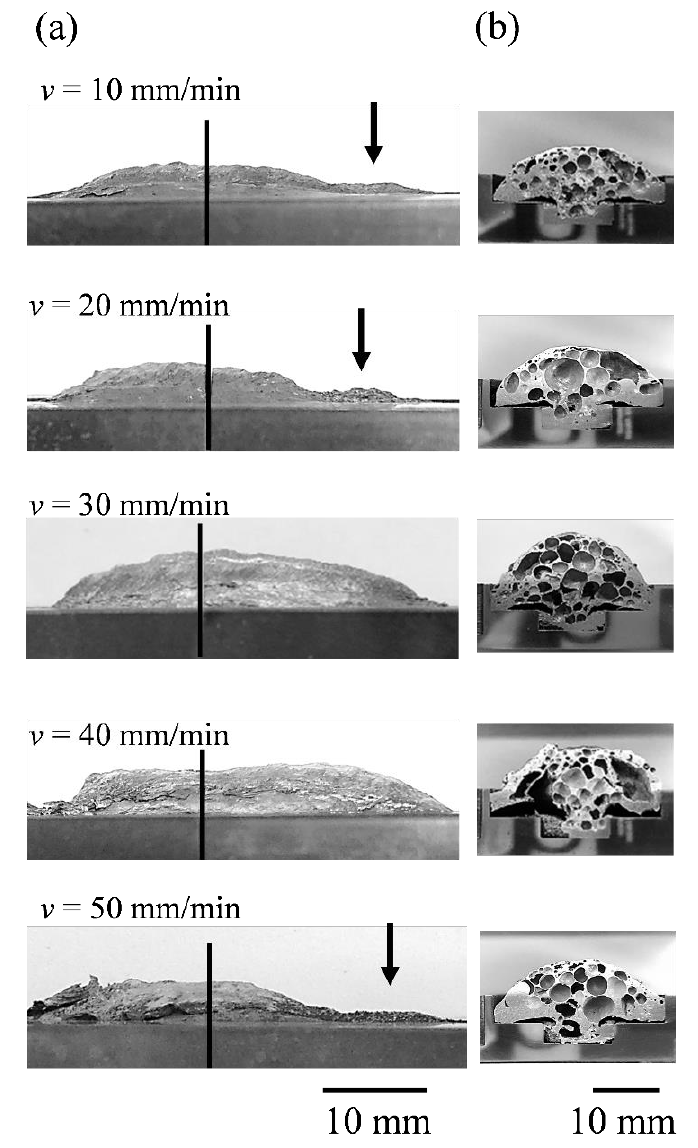
Figure 9. ( a ) Porous Al obtained at various v . ( b ) Cross sections of porous Al shown in ( a